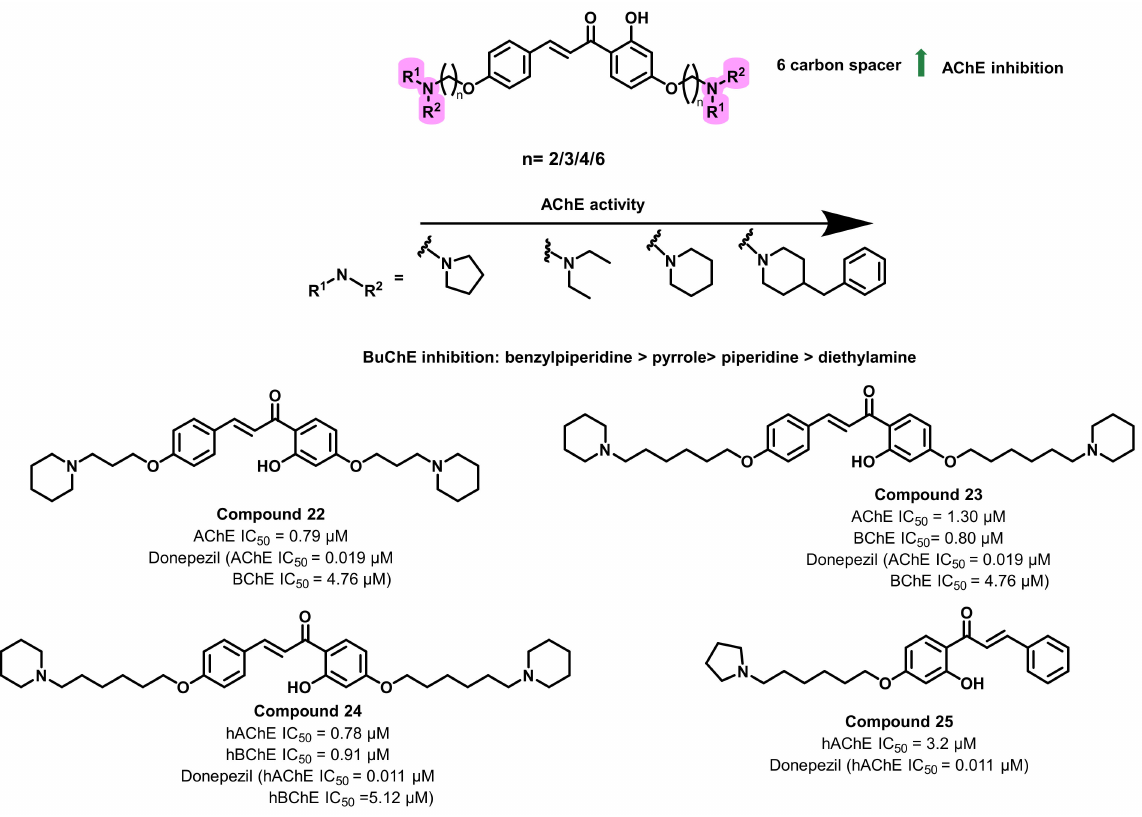
Figure 23. Chalcone- O -alkylamine derivatives reported by Bai et al.